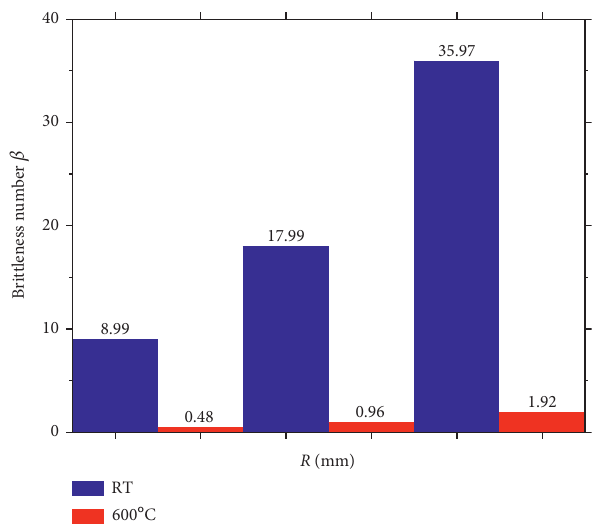
Figure 14: Baˇzant’s brittleness number of three sizes of specimens (blue indicates untreated granite samples, and red indicates granite samples treated at 600 °